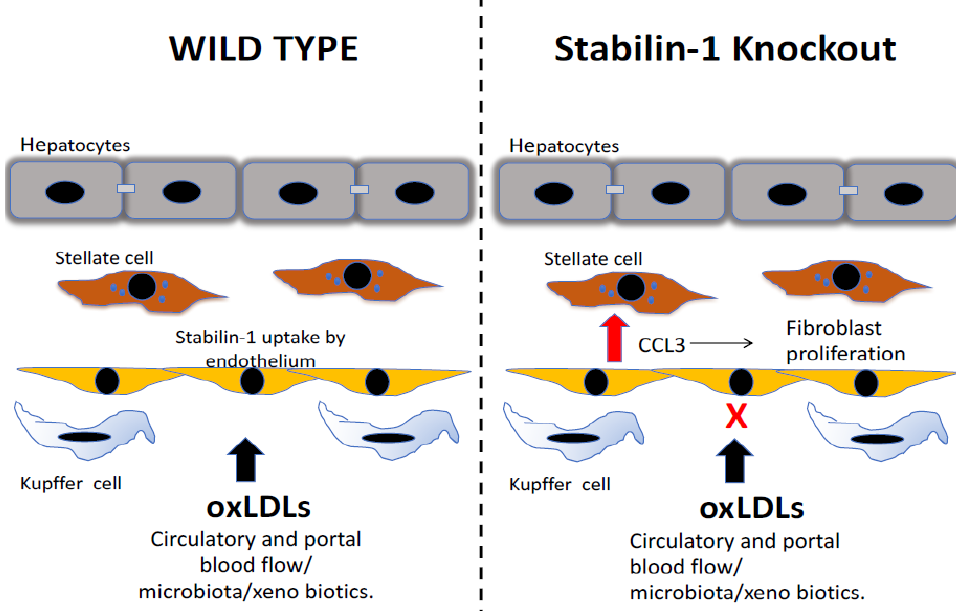
Figure 4. The scavenging role of stabilin maintains homeostasis in the liver by the uptake of products of oxidative stress. Stabilin-1 contributes to the hepatic uptake of circulating oxidized low-density lipoproteins (oxLDLs). In the setting of stabilin-1 deficiency, these oxLDLs lead to a proinflammatory responsespecifically, leadingtoincreasedlevelsofthechemokineCCL3, whichdrivestheproliferationof liver-resident fibroblasts and causes an increase in collagen fibres in the livers of stabilin-1 knockout mice.